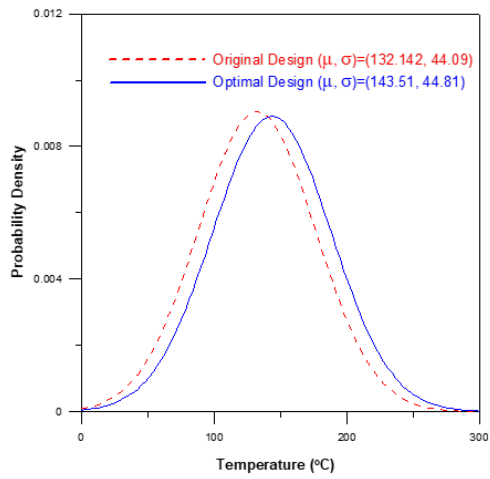
Figure 11. Comparison of temperature distributions in original process design and optimal process design.